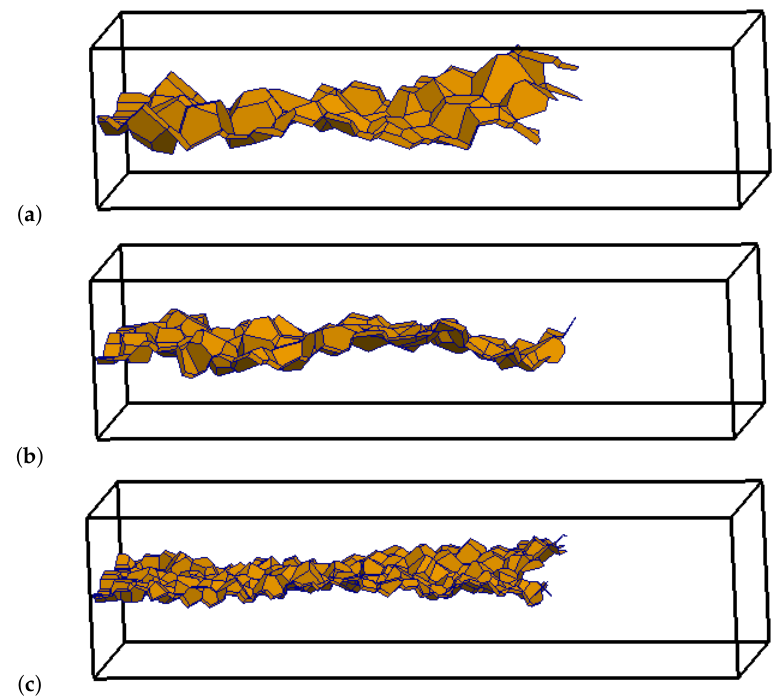
Figure 12. Crack patterns for ( a ) coarse; ( b ) medium; and ( c ) fine network for a load-point-displacement of δ = 0.15 mm in Figure 11. The shaded polygons represent the mid-cross-sections of elements with ˜ w > 10 µ